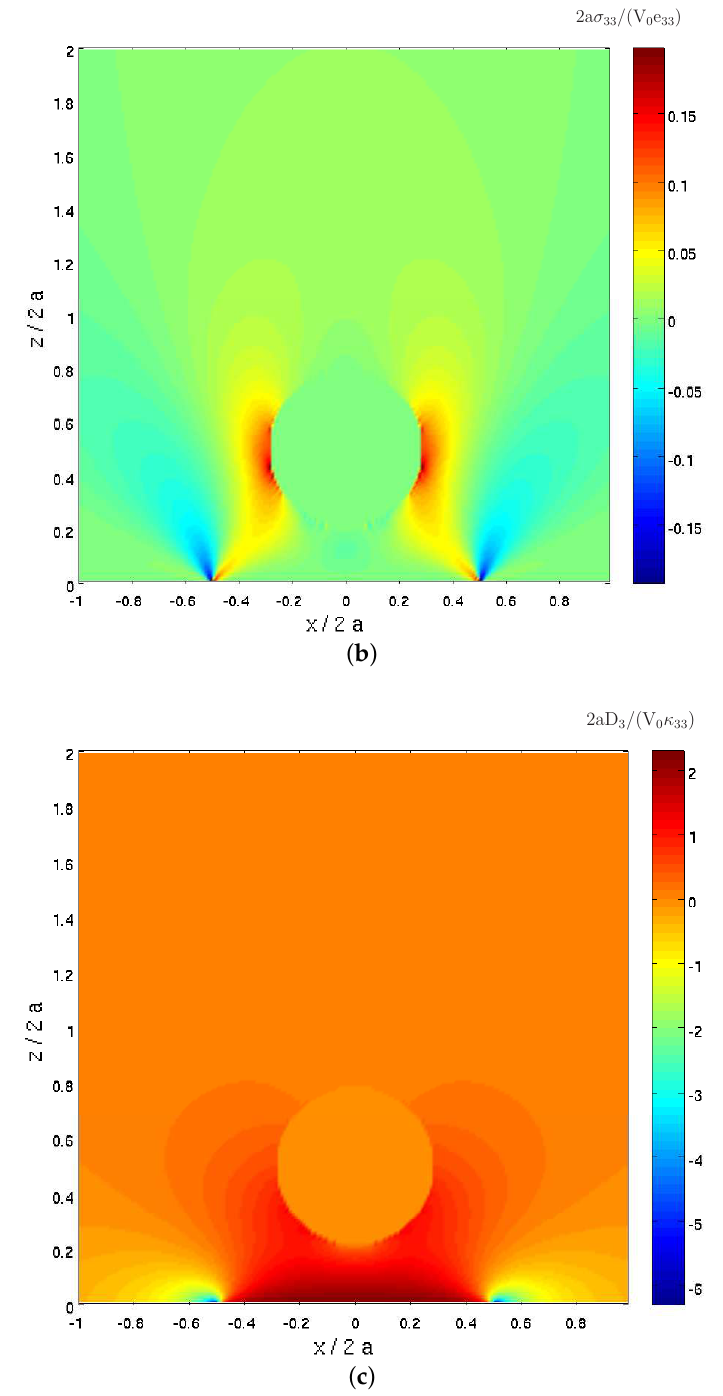
Figure 3. A piezoelectric (PZT-7A) half-plane attached to an electrode of electric potential V 0 at z = 0 with a defect in the form of an embedded cavity. ( a ) The variations of the induced normal stress σ 33 and electric displacement D 3 along x 1 at z / a = 1. ( b ) The distribution of the induced normal stress σ 33 in the region − 1 ≤ x /2 a ≤ 1, z /2 a ≤ 2. ( c ) The distribution of the normal electric displacement D 3 in the region − 1 ≤ x /2 a ≤ 1, z /2 a ≤